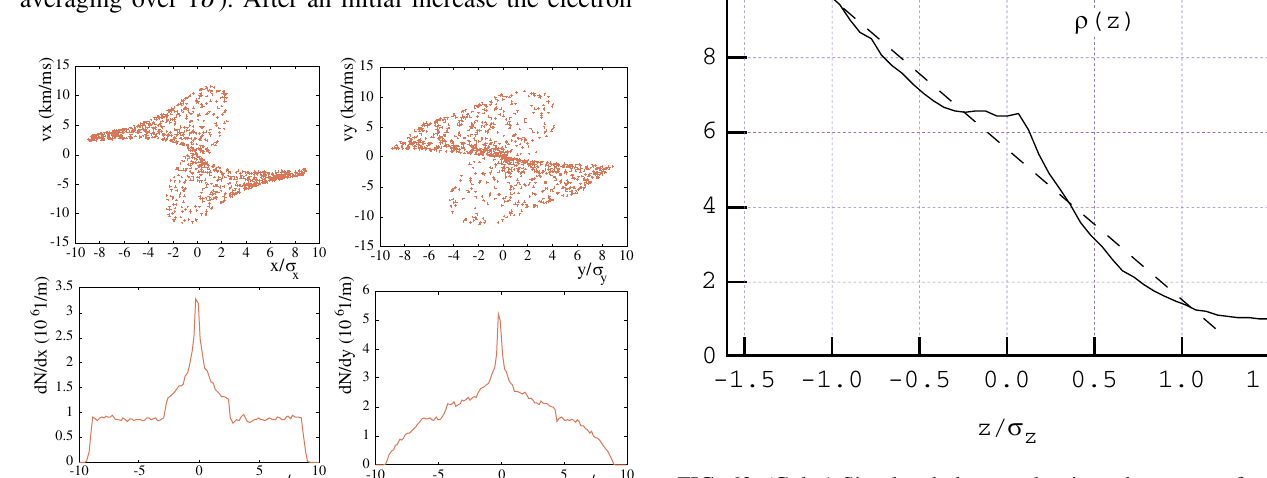
FIG. 62. (Color) Simulated electron density enhancement factor (cid:31) (cid:4) z (cid:5) within a 1 (cid:16) ellipse around the beam axis as a function of the longitudinal position z within the bunch for the PEP-II LER pumping straight chamber; the bunch head is on the right; the straight line is a freehand approximation [86].